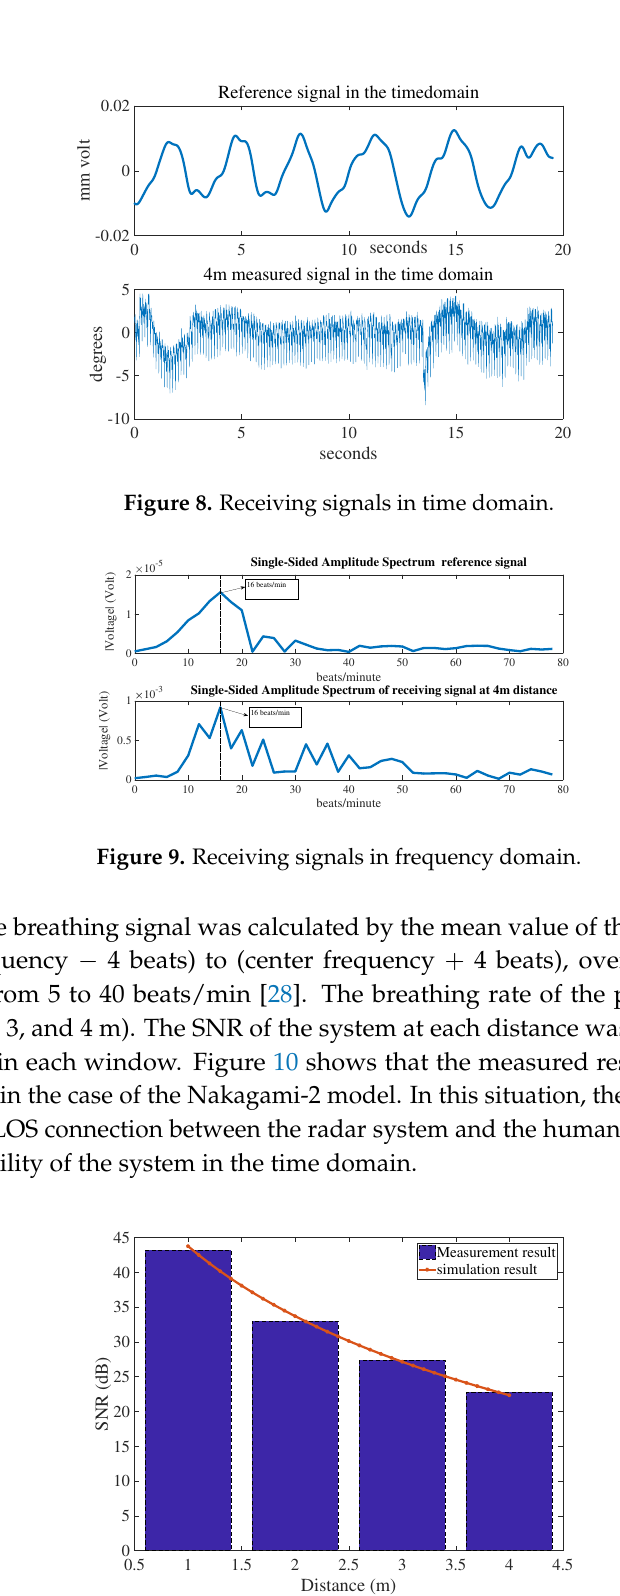
Figure 10. Signal-to-noise ratio (SNR) of the